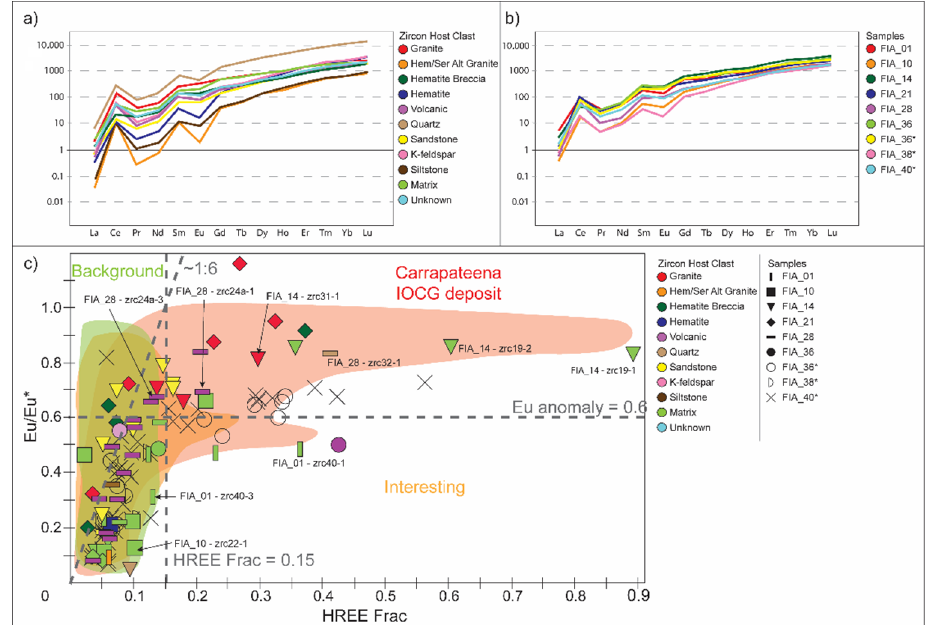
Figure 7. Geochemical plots highlighting the zircon rare-earth element chemistry. ( a ) Chondrite-normalised REE diagram for zircon in the basal diamictite of the cover sequence, coloured according to hosting clast type. Data normalised to [52]; ( b ) chondrite-normalised REE diagram for zircon in cover sequence basal diamictite, coloured according to drill hole sample. Data normalised to [52]. Sample and drill hole locations are shown in Figure 1b; ( c ) heavy rare-earth element (HREE) fractionation vs. Eu/Eu* ratio. HREE Frac = Yb N /Gd N . Data coloured by the type of clast the zircon is hosted by within the basal diamictite. Data shape shows the drill hole from which the sample was taken. Red shading: chemistry of zircon from Donington Suite basement from the Carrapateena area. Orange shading: chemistry of zircon from regional altered samples of the Donington Suite. Green shading: chemistry of zircon from unaltered samples of the Donington Suite. Basement zircon chemistry data taken from [15]. Annotated zircon grains correspond to the internal textures of individual grains shown in Figure 4. * Represents samples analysed from zircon mounts where host clast is